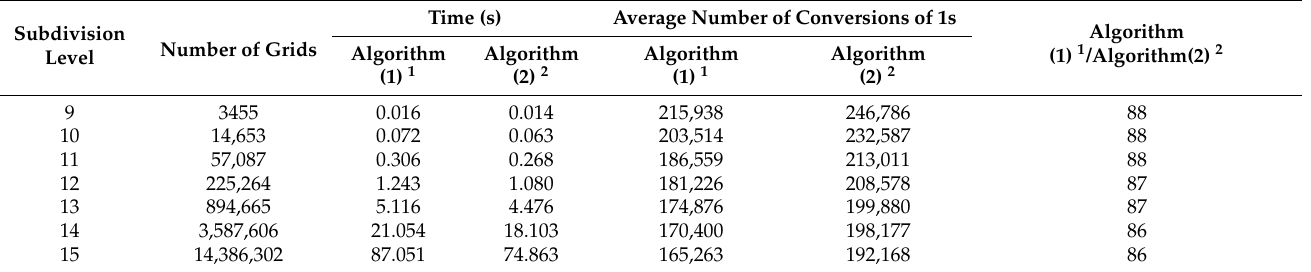
Table 10. Comparison table of the algorithms efficiency of conversion from Goodchild encoding to TRQ encoding.